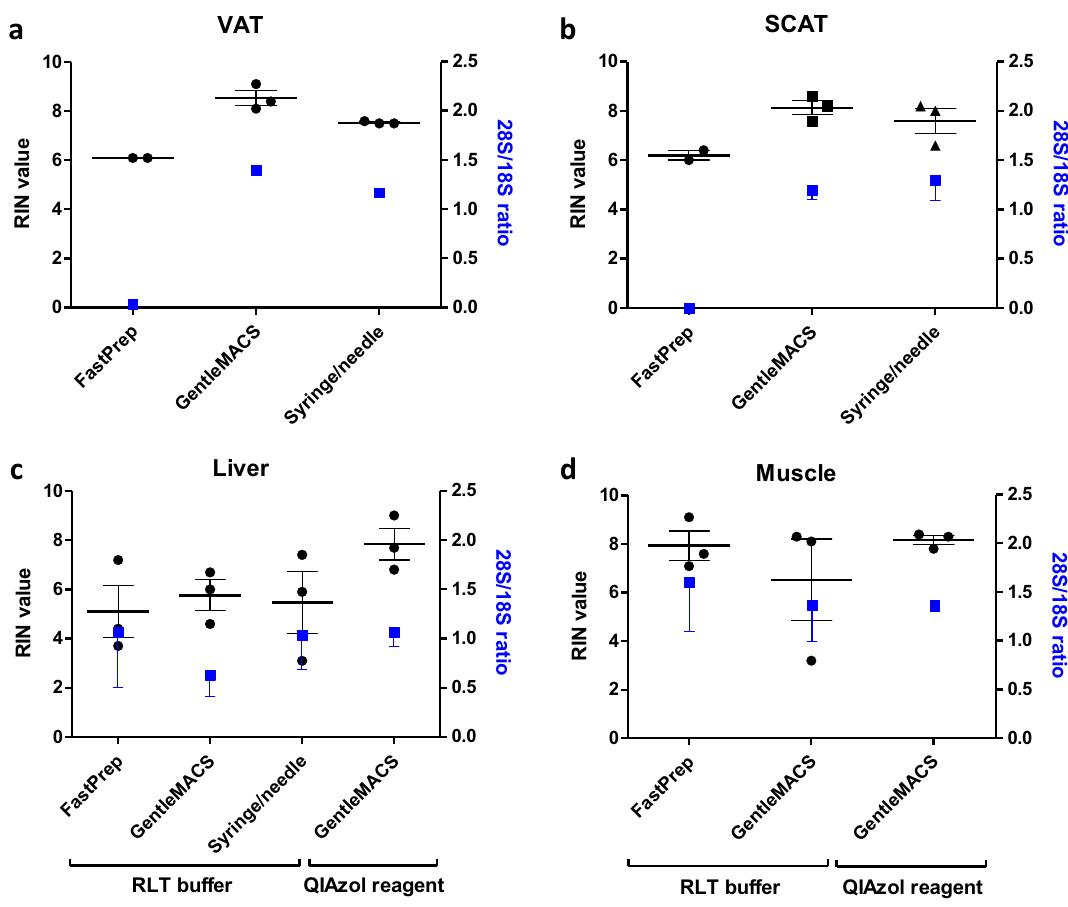
Figure 3. RNA quality obtained with different homogenization buffers and methods. RIN and 28S/18S ratios were determined using Agilent 2100 Bioanalyser and RNA 6000 Nano chips. Mean values ± SEM are shown for VAT ( a ), SCAT ( b ), liver ( c ), and muscle ( d ). VAT visceral adipose tissue, SCAT sub-cutaneous adipose tissue. FastPrep for FastPrep-24 Instrument, GentleMACS for GentleMACS